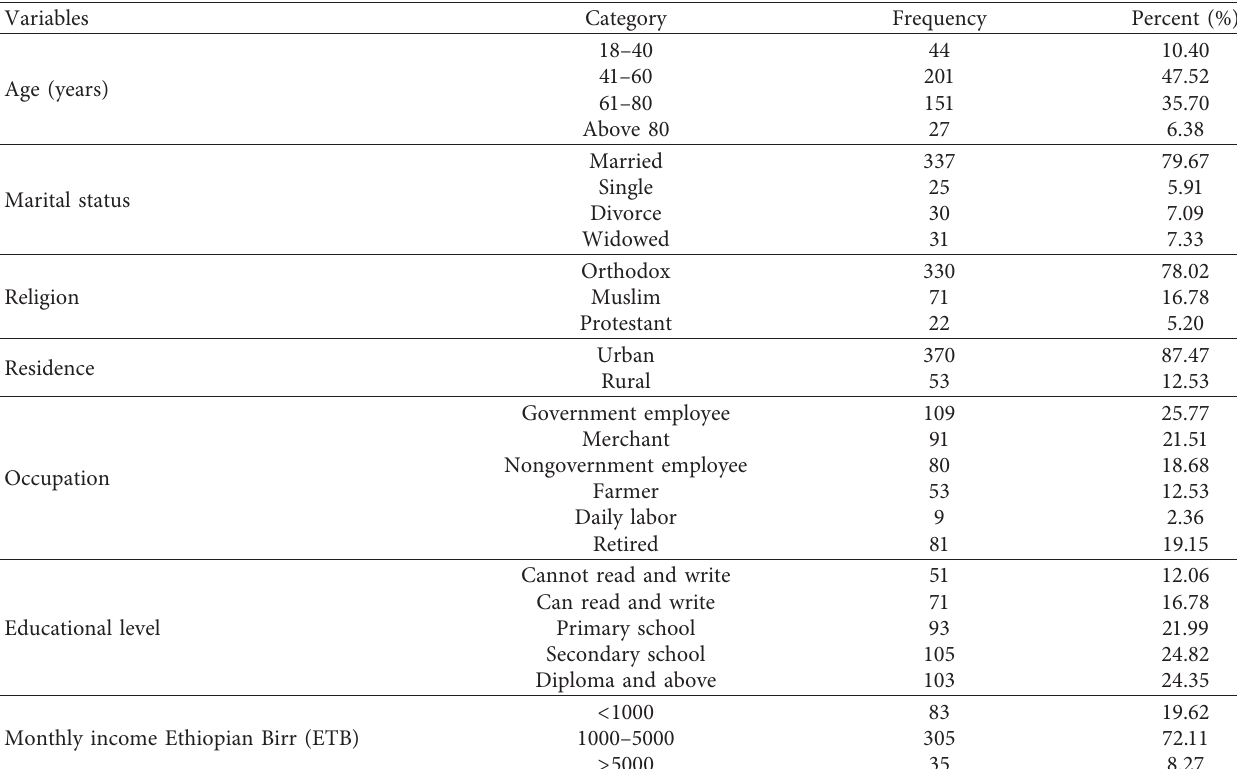
Table 1: Sociodemographic characteristics of hypertensive patients attending governmental health institutions in Gondar city, Northwest Ethiopia, 2021 ( n �